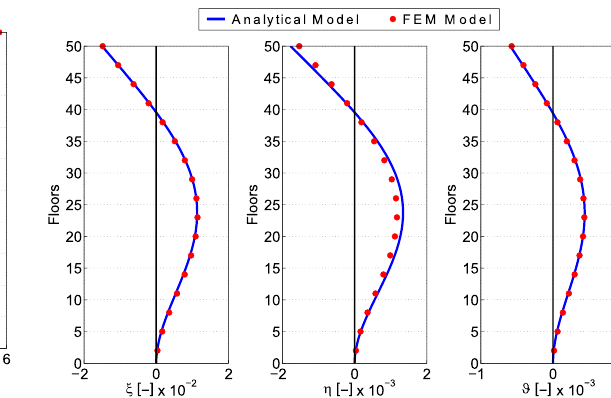
Figure 4: Normalized eigenvector components of the 1st mode shape